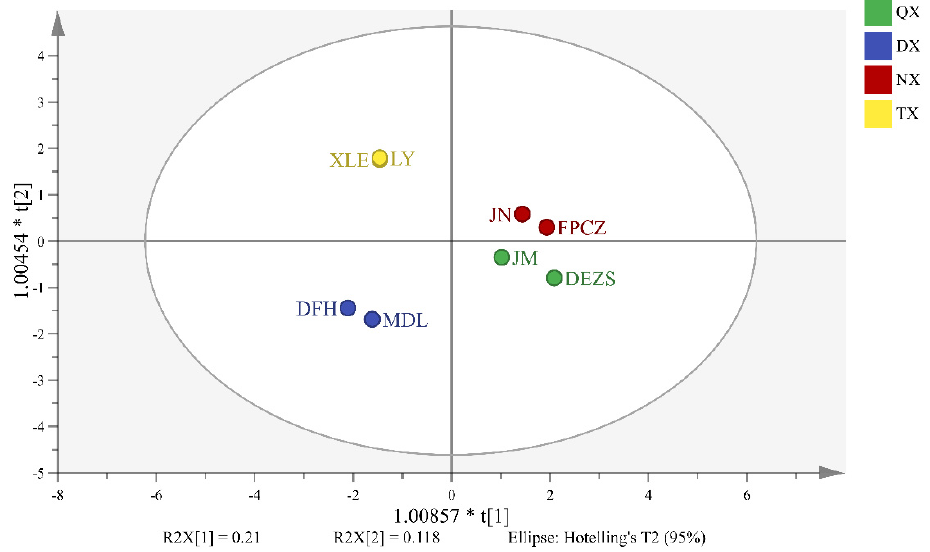
Figure 4. Score plot of OPLS-DA models of headspace volatiles of P. mume cultivars with the statistical parameters (R2X = 0.938, R2Y = 0.994, Q2 = 0.776). Table 1. Volatile biomarkers for the identification of P. mume cultivars with four aroma types. Strong-Scented Strong-Scented vs. Light-Scented